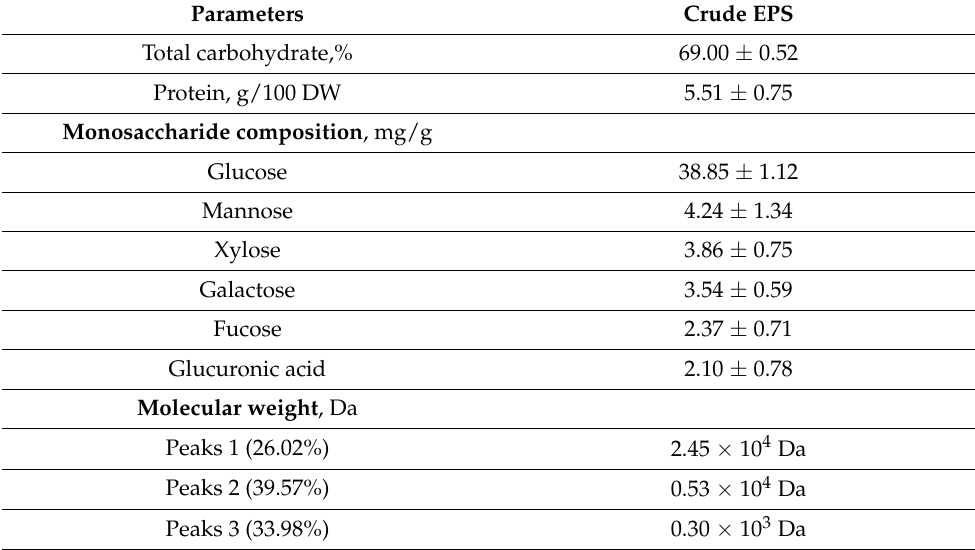
Table 4. Monosaccharide composition and molecular weight of soluble crude exopolysaccharides (EPS) from T. versicolor NBIMCC 8939. Parameters Crude EPS Total carbohydrate,% 69.00 ± 0.52 Protein, g/100 DW Monosaccharide composition , mg/g